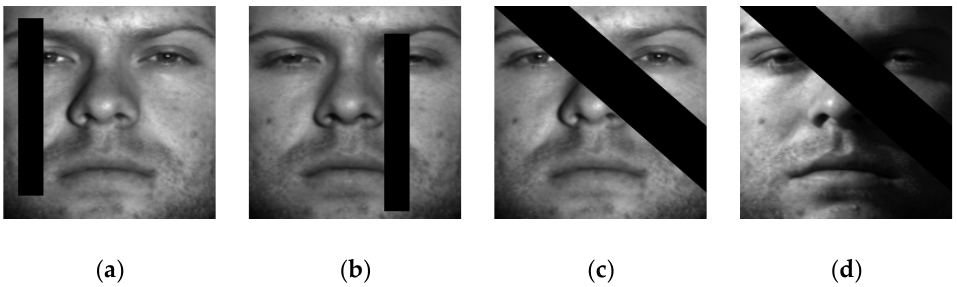
Figure 14. Test samples with vertical occlusion of 10% and diagonal occlusion of 20%: ( a , b ) face